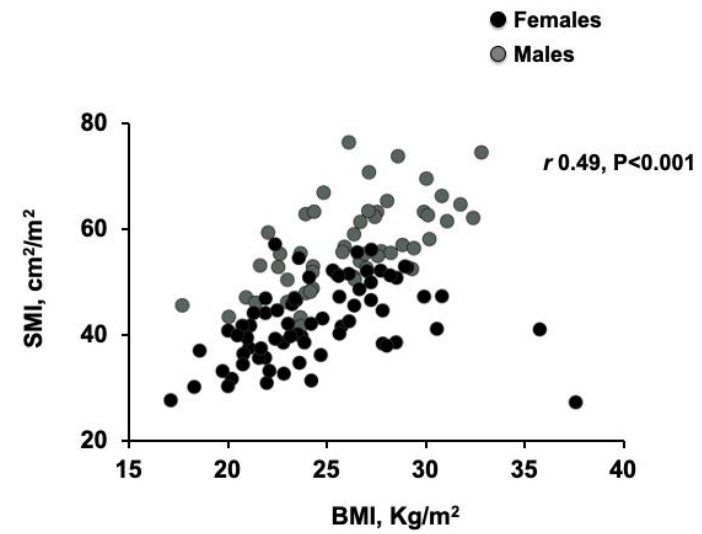
Figure 2. Scatter graph depicting correlations between skeletal muscle index (SMI) and body mass index (BMI) in donors. Moderate correlation (Pearson’s correlation) between SMI and BMI in donors ( r = 0.49, p < 0.001).